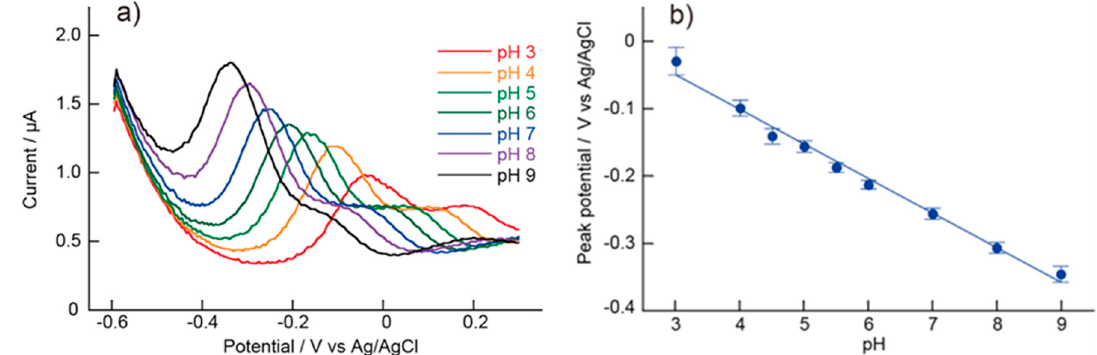
Figure 5. ( a ) Differential pulse voltammetry (DPV) Voltammogram in phosphate buffer solution (100 mM) at pH = 3–9 using (PAH/AA-PMA) 5 -modified electrode. ( b ) Plot of the peak potential vs. pH.